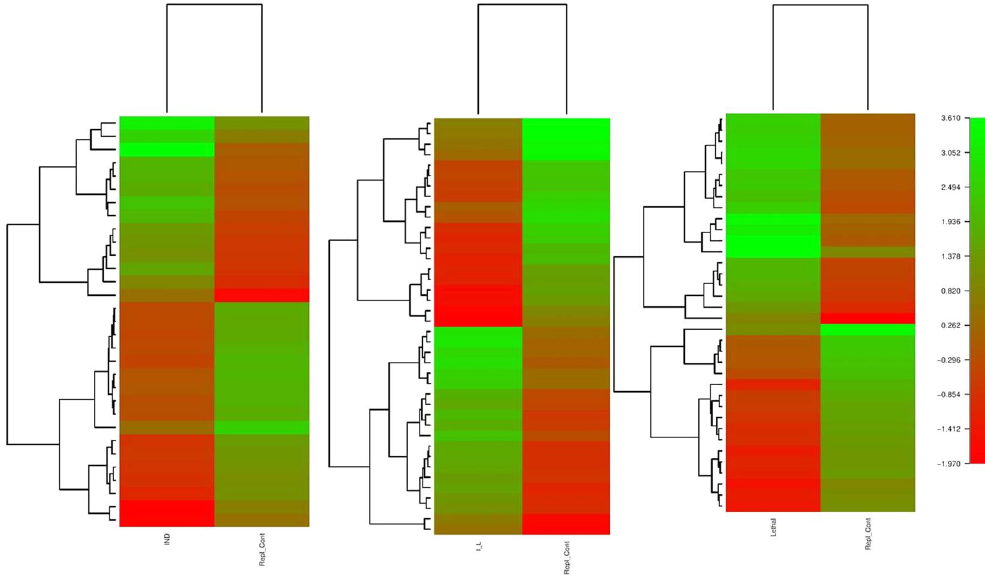
Figure 3. Heat stress profiling of banana under different stress conditions viz Induction, Induction followed by lethal, Lethal stress: The heat map was constructed using R